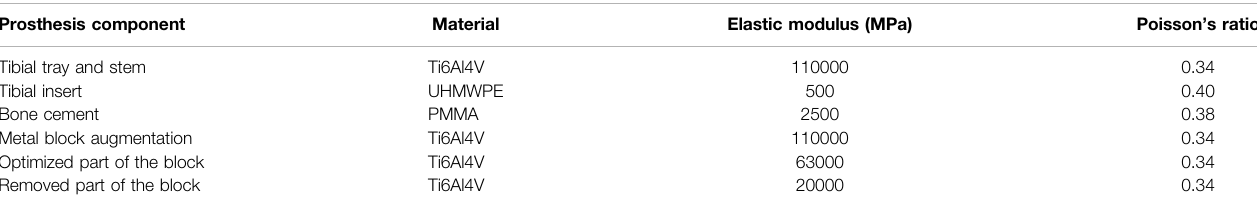
TABLE 1 | Material properties of the tibial components. Prosthesis component